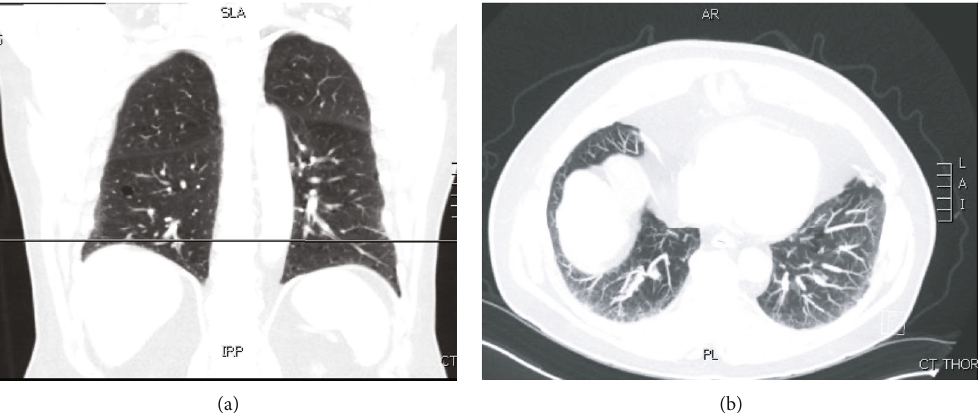
Figure 1: Case 1. (a) CT scan chest coronal view demonstrating subpleural reticulation within the periphery of the lung as well as thin- walled cysts of various sizes (arrows). (b) CT chest using maximum intensity projection protocol demonstrating areas with the most disease activity and least vasculature